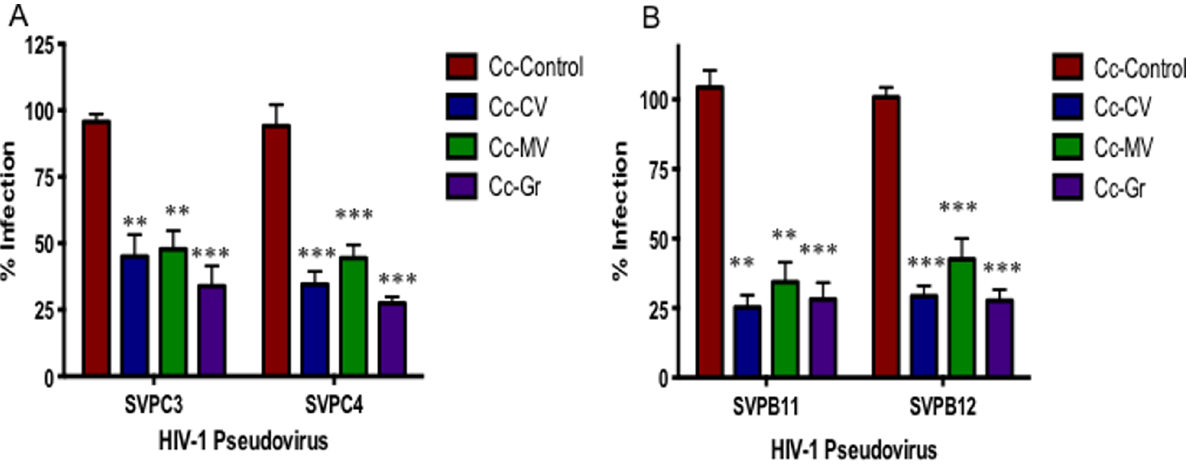
Figure 4. Anti-viral lectin viral blocking assay. Cc-Control, Cc-CV, Cc-MV and Cc-Gr were combined with TZM-bl cells and 200TCID50 clade B (SVPB11, SVPB12) or clade C (SVPC3, SVPC4) HIV-1 pseudovirus and incubated for 48 hours. Infection rate was measured indirectly using a mammalian b -galactosidase assay and is given as a percentage, normalized to wells containing virus + TZM-bl cells, with background for uninfected TZM-bl cells subtracted out. The assay was set up in quadruplicate and repeated a minimum of 3 times. p values represent difference between control and each lectin individually. *p , 0.01, **p , 0.001.